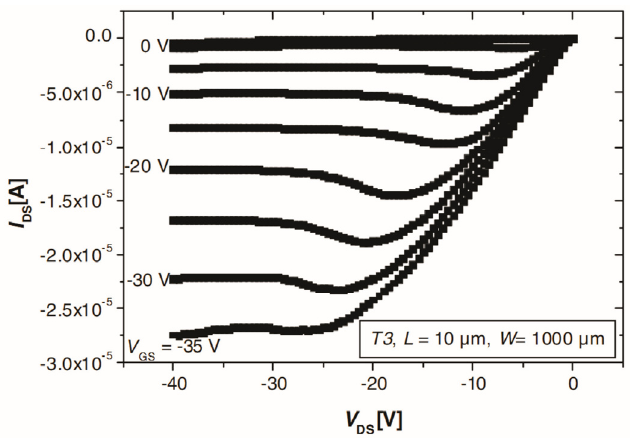
Figure 7. Output characteristics of an inverted coplanar pentacene OTFT using a high- k dielectric (L = 10 μ m, W = 1000 μ m and t ins = 200 nm). Reprinted from [47], with permission